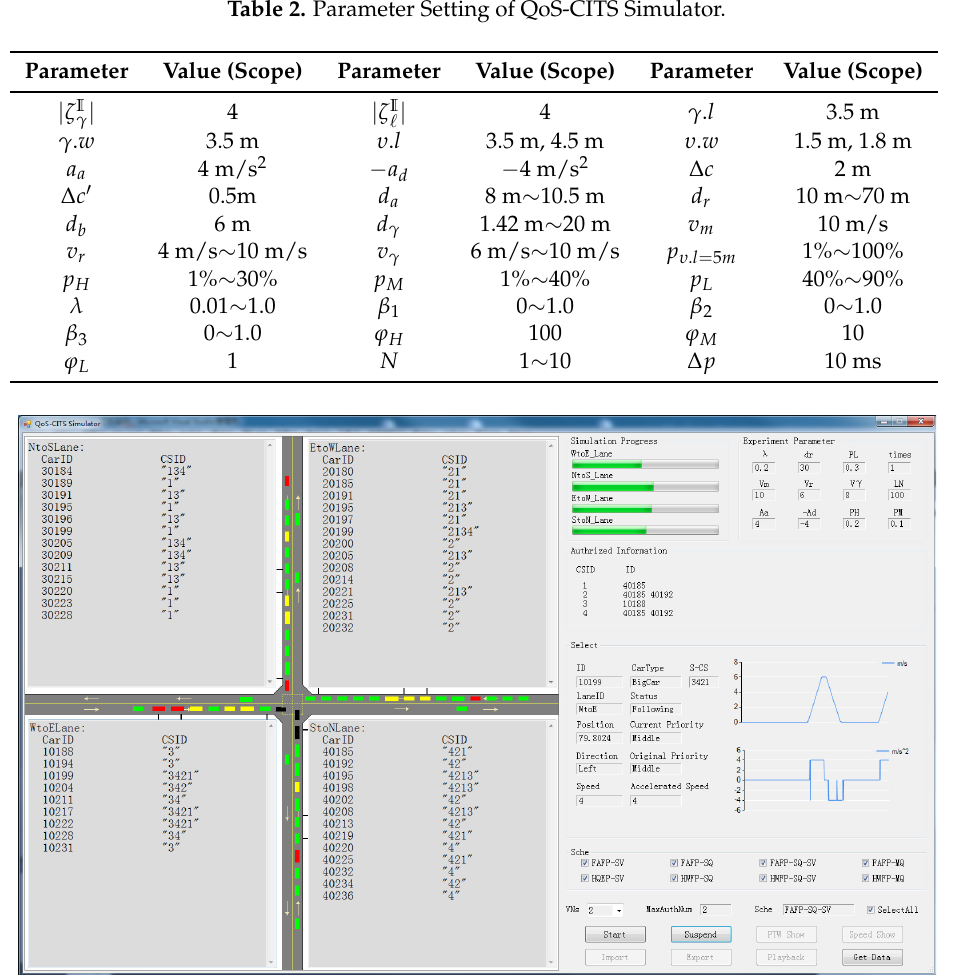
Table 2. Parameter Setting of QoS-CITS Simulator.